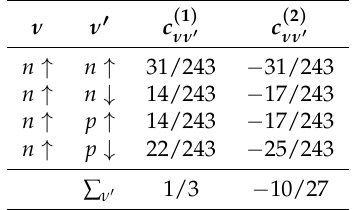
Table A1, the equivalent results hold also for the other nucleon states, if the interaction is invariant with respect to the isospin variables. Table A1. The values of the matrix elements c